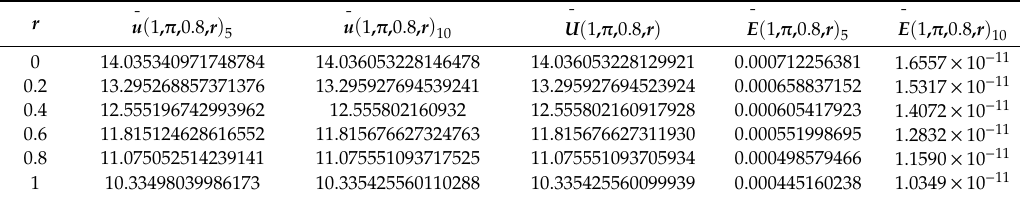
Table 11. Solution and accuracy of fifth and tenth order double parametric fuzzy HPM solutions for Equation (32) at t = π , x = 1 and b = 0.8 for all r ∈ [ 0,1 ]